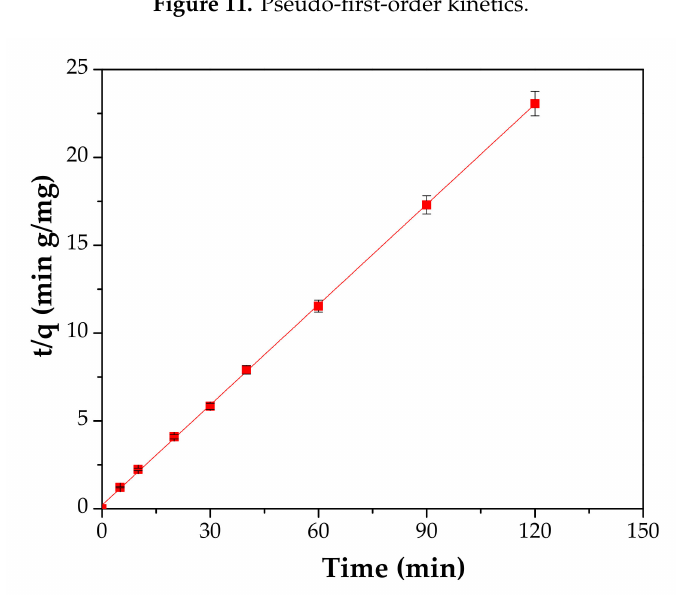
Figure 11. Pseudo-first-order kinetics.